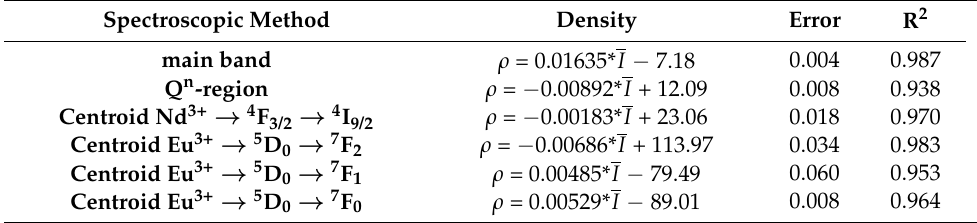
Table A2. Linear fitting equations for the various spectroscopic methods to calculate density as function of the mean I ; the error was estimated as the mathematical mean of the difference ( ρ measured − ρ calibration ) of the cylinders densified at various P max